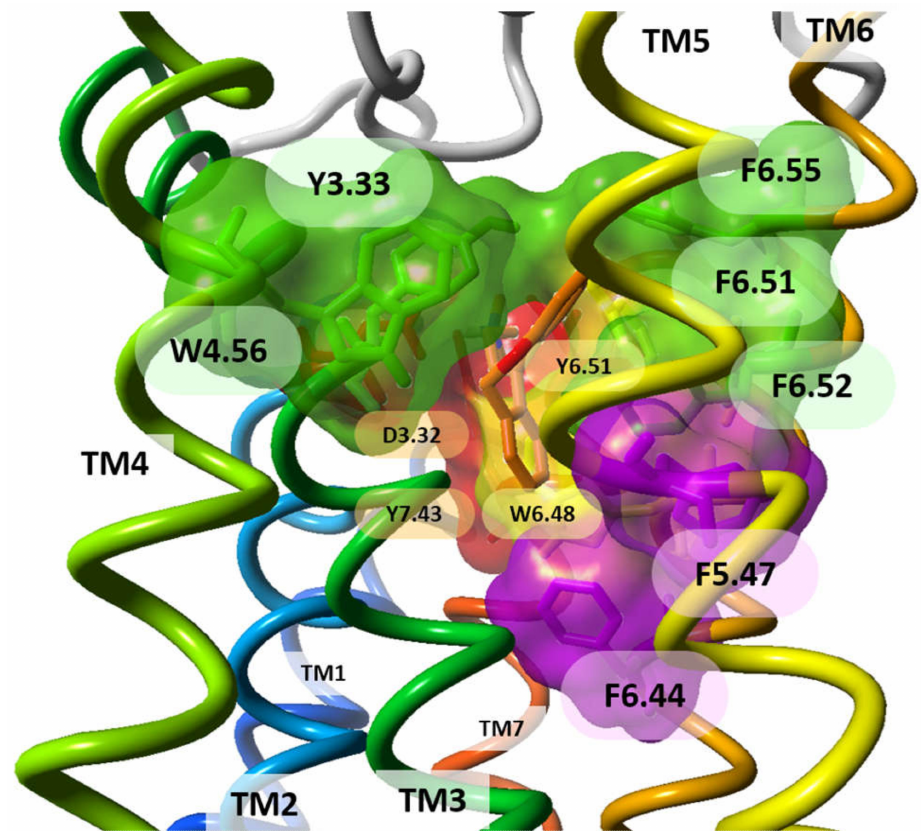
Figure 3. The areas of amino acids surrounding doxepin in the crystal structure of H 1 R: (red) the amine-binding region; (green) the upper aromatic region; (purple) the lower aromatic region; (yellow) the boundary amino acids participating in both amine-binding and aromatic regions. Doxepin is shown with its carbon atoms colored in orange. Side view of the receptor. TM helices are colored from blue (TM1) to red